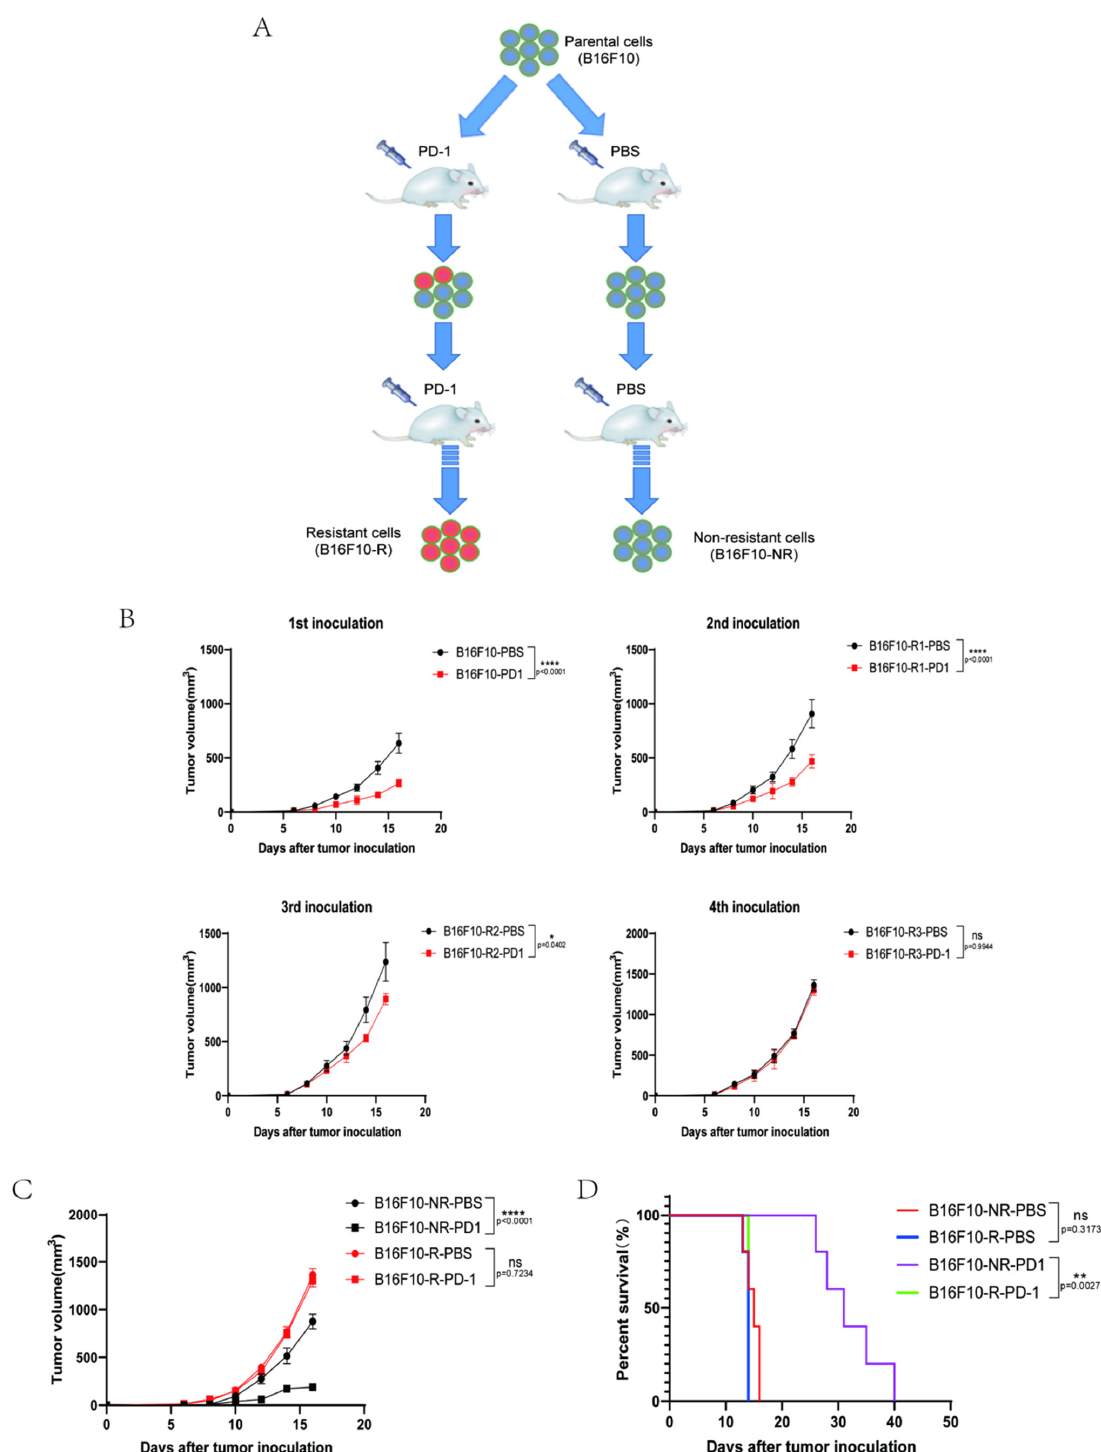
Figure 1. Construction of B16F10 tumour model resistant to anti-PD-1 therapy. ( A ) Construction method of anti-PD-1-resistant B16F10 tumour cells. ( B ) Tumour growth curves for four rounds of anti-PD-1-resistant B16F10 tumour selection ( n = 6/group, two-way ANOVA test, Sidak). ( C ) Growth curves of B16F10-NR and B16F10-R tumours. Mice were treated with either pembrolizumab or PBS ( n = 6–8/group, two-way ANOVA test, Tukey). ( D ) Mouse survival curves for B16F10-NR and B16F10-R tumours. Mice were treated with either pembrolizumab or PBS ( n = 6–8/group, log-rank test of survival curve); ns, not statistically significant; * p < 0.05; ** p < 0.01; **** p <